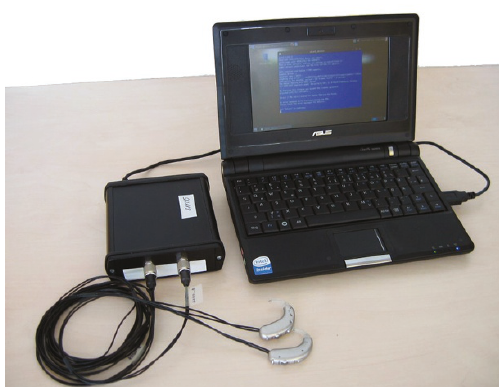
Figure 3: PHS prototype based on the Asus Eee PC, with a dimension of 22 × 15 cm and a weight of 1.2 kg, including the sound card and audio